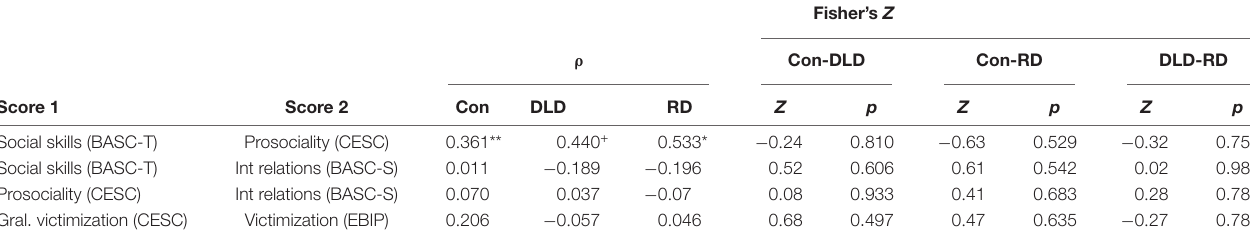
TABLE 4 | Spearman correlation coefficients ( ρ ) of comparable scores belonging to different questionnaires for each group separately ( n Control = 19; n DLD = 14; n RD = 21) and Fisher’s Z